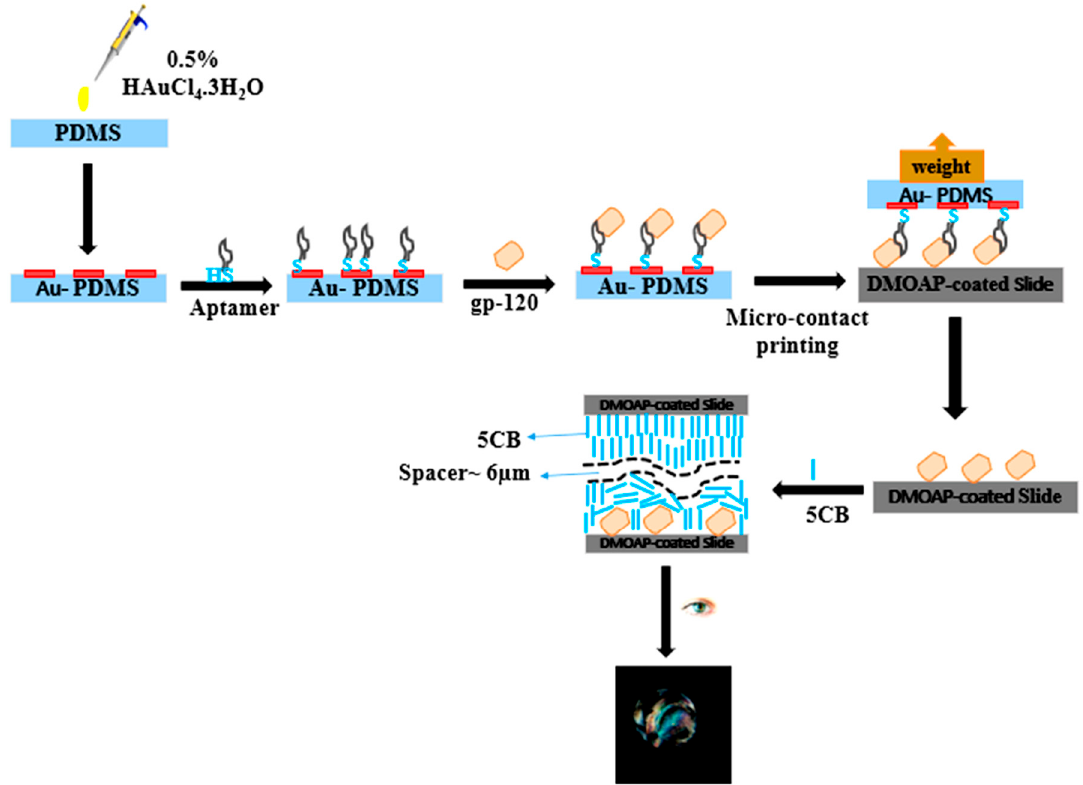
Figure 1. Schematic illustration of the fabrication of AuNPs–PDMS stamp and biorecognition pro- cess, including inking with probe aptamer, stamping and patterning target protein gp-120 on DMOAP-coated glass slide through